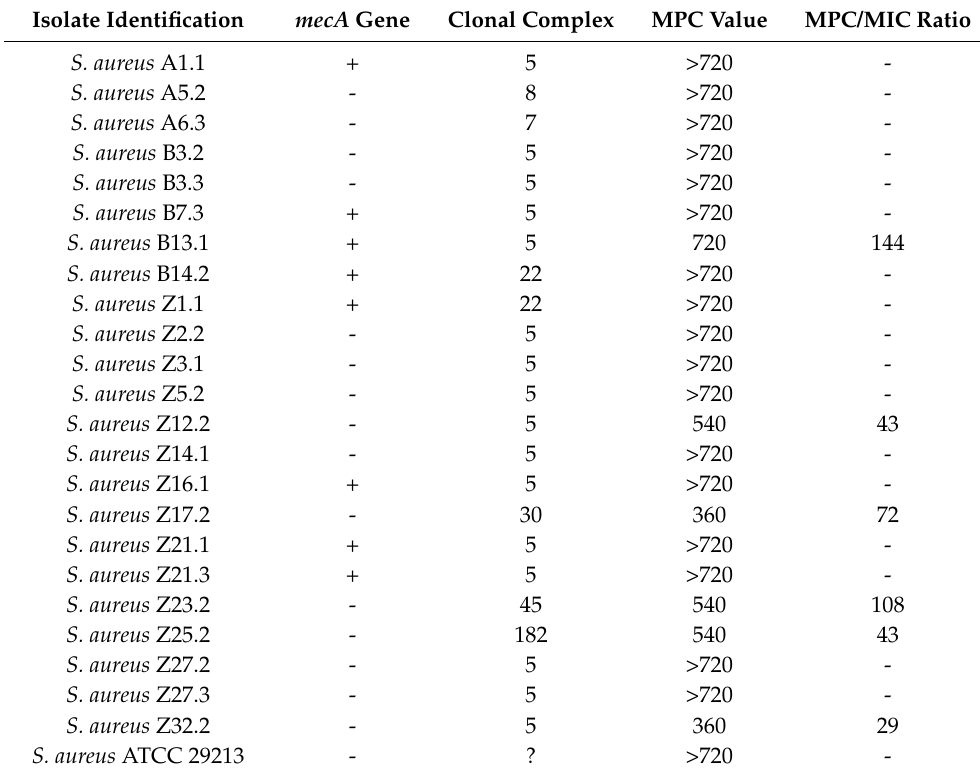
Table 1. Nisin mutant prevention concentration (MPC) values and MPC/MIC ratio for the 24 S. aureus isolates under